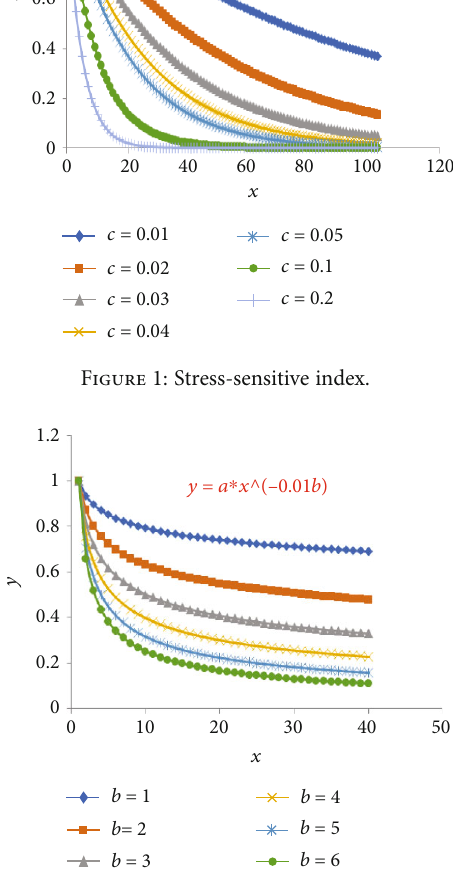
Figure 2: Stress-sensitive power function.